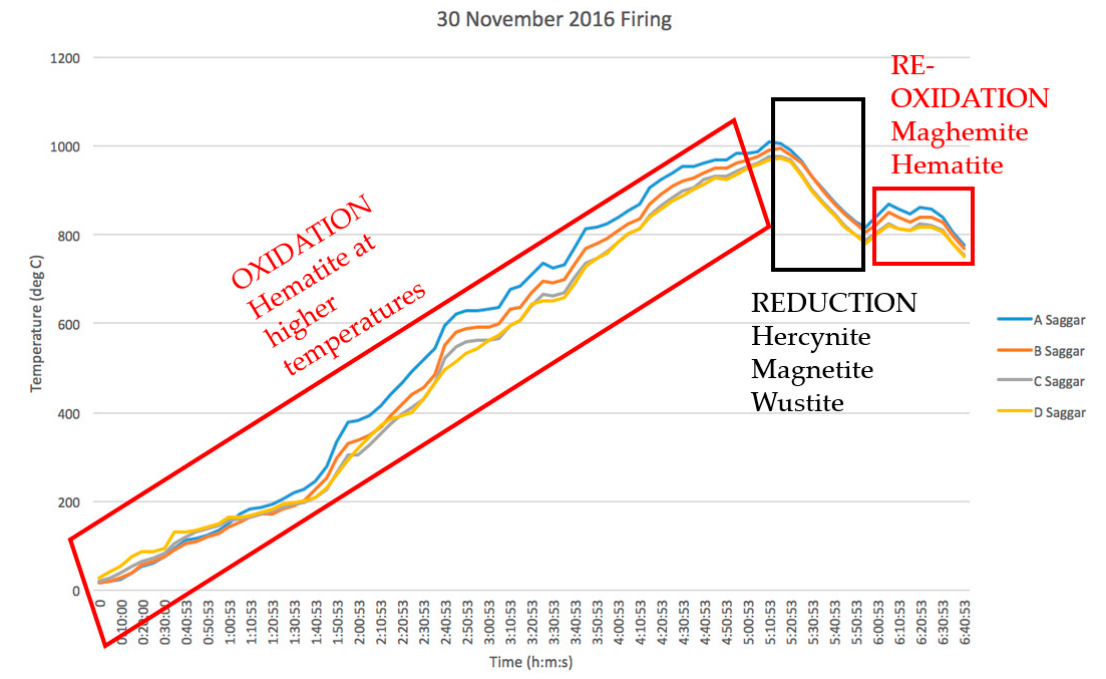
Figure 4. A graphic representation of the single three-phase firing sequence and some of the associated iron oxides as suggested in the scientific literature. This graph resulted from data gathered in a November 2016 test firing.